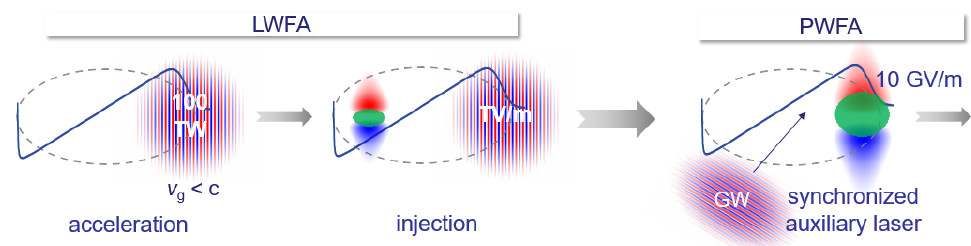
Figure 1. Schematic visualization of hybrid plasma wakefield acceleration. A 100 TW-scale laser pulse drives a wakefield (the blue line shows the profile of the longitudinal electric field on-axis); an electron beam is produced in the LWFA stage and then used as a driver for the attached PWFA stage. Here, the inherent advantages of PWFA for acceleration and injection and the inherent synchronization can be